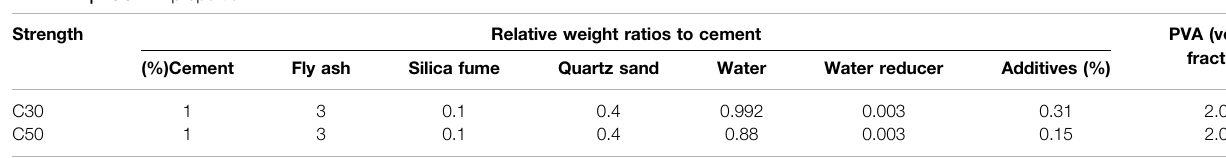
TABLE 2 | ECC mix proportion.